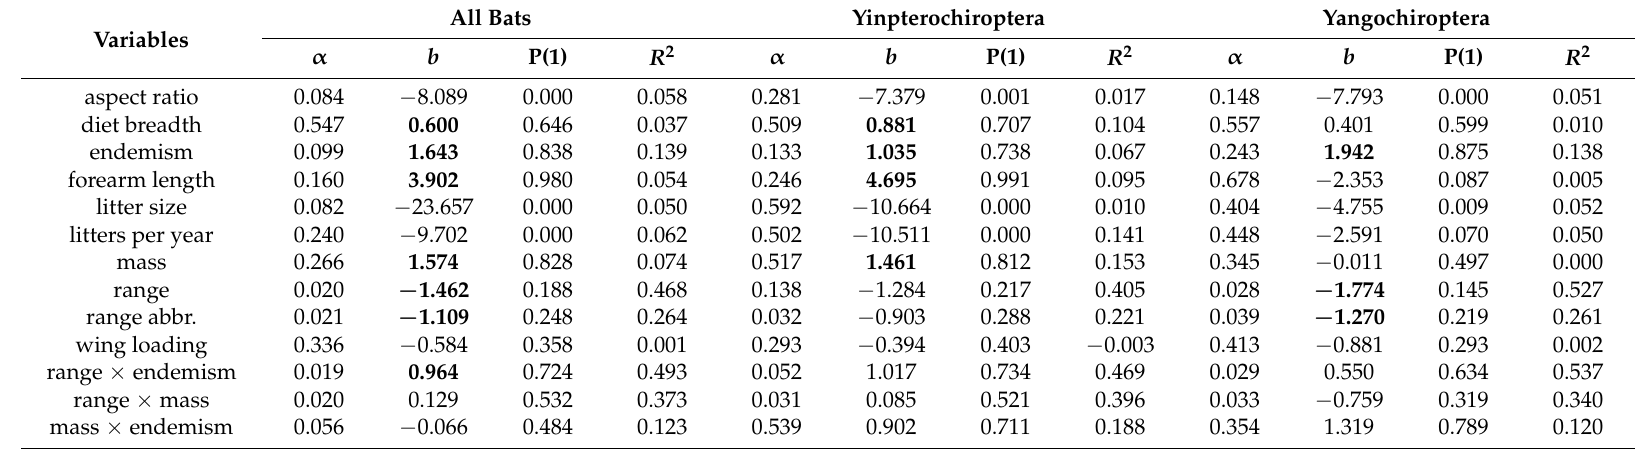
Table 2. Results of phylogenetic logistic regressions on single predictors and interactions to identify important correlates of extinction risk in bats. Results for the categorical variable trophic level is reported in the main text. The variable “geo range abbr.” excludes bats listed at threaten owing to Criteria B alone. The parameter α represents the phylogenetic correlation parameter, where values near 0 indicate strong phylogenetic signal and values approaching 0.98 indicates very weak phylogenetic signal based on the root age of our tree. Regression coefficients ( b ) are bolded for variables significant at p ≤ 0.05 according to a Wald test. P(1) represents the probability of odds of increasing threat with a unit increase in the variable. R 2 values are estimated by the Cox & Snell equation with the Nagelkerke